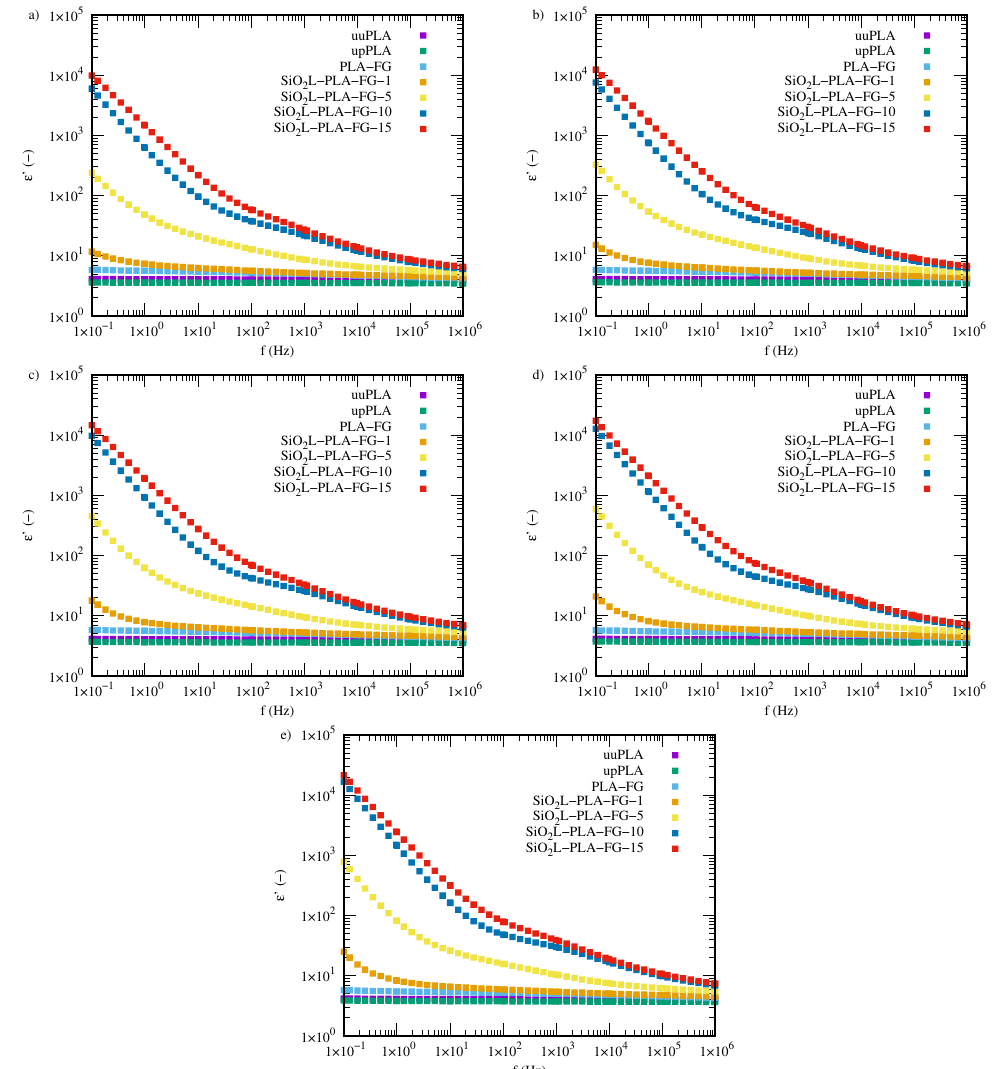
Figure A1. The real part of complex permittivity of silicon-dioxide–lignin nanocomposites as a function of frequency for ( a ) 298.15 K, ( b ) 303.15 K, ( c ) 308.15 K, ( d ) 313.15 K, and ( e ) 318.15